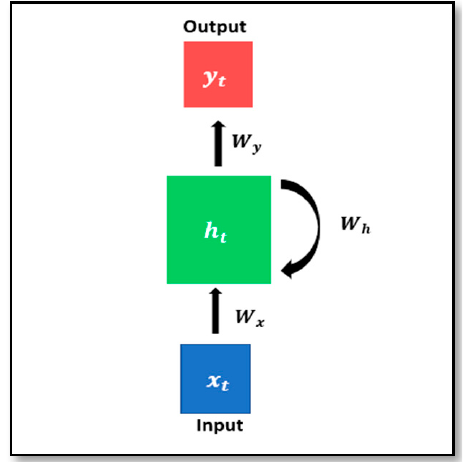
Figure 3. Basic recurrent neural network (RNN).